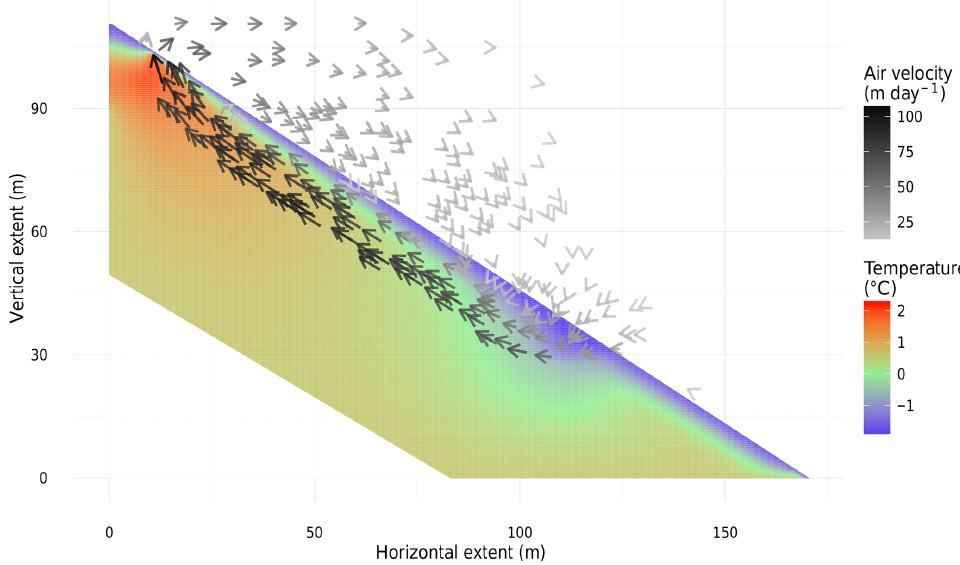
Figure 3. Simulated temperature distribution (colours) and air current vectors in the talus slope for the open experiment (OPE) for day 300 (winter circulation). The intensity of the circulation is marked by the grey/black vector arrows and is given in mday − 1 .